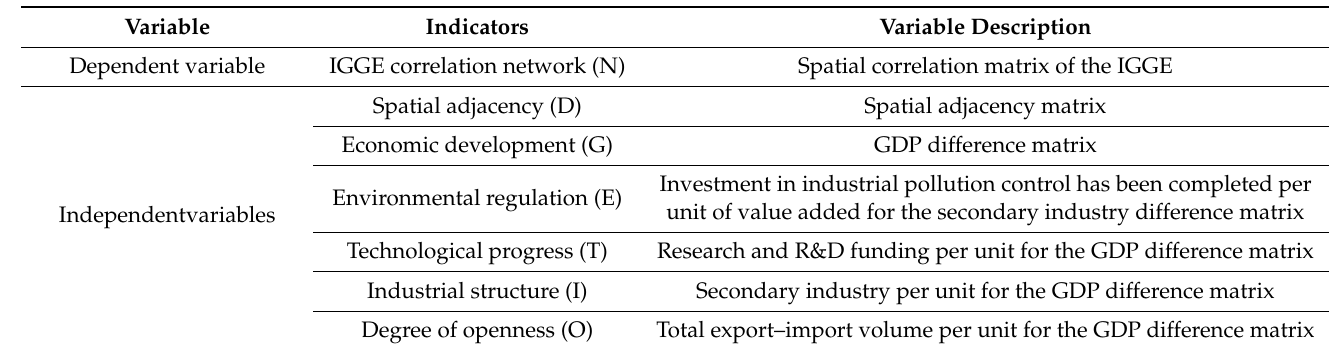
Table 3. Variables and